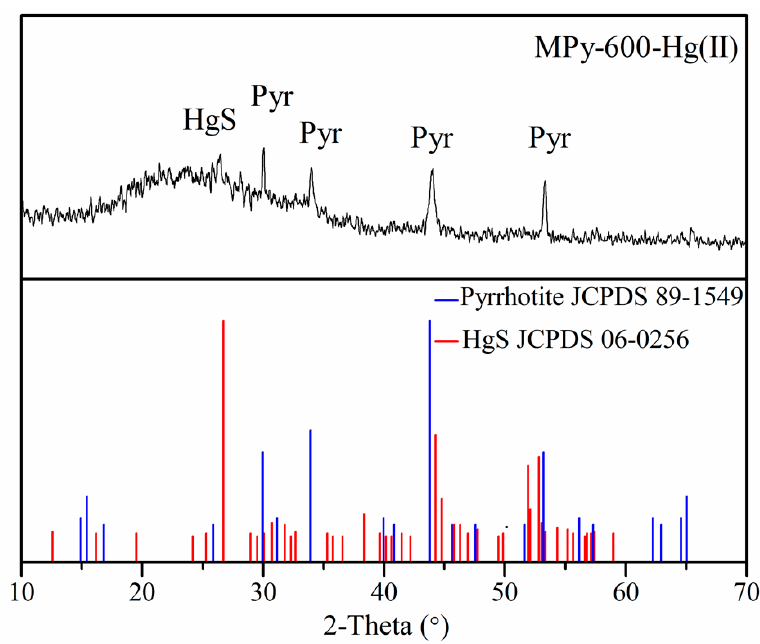
Figure 7. The XRD pattern of the reacted MPy-600 material. Pyr—pyrrhotite.